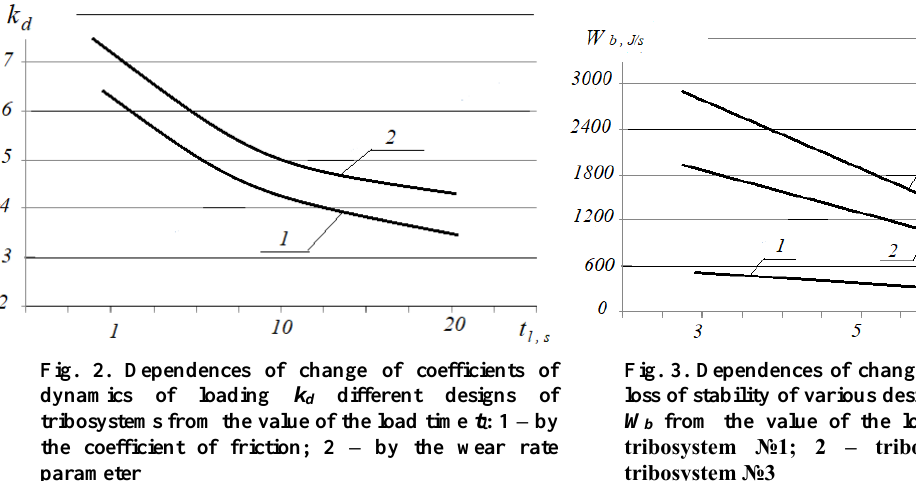
Fig. 2. Dependences of change of coefficients of dynamics of loading k d different designs of tribosystems from the value of the load time t l : 1 – by the coefficient of friction; 2 – by the wear rate parameter